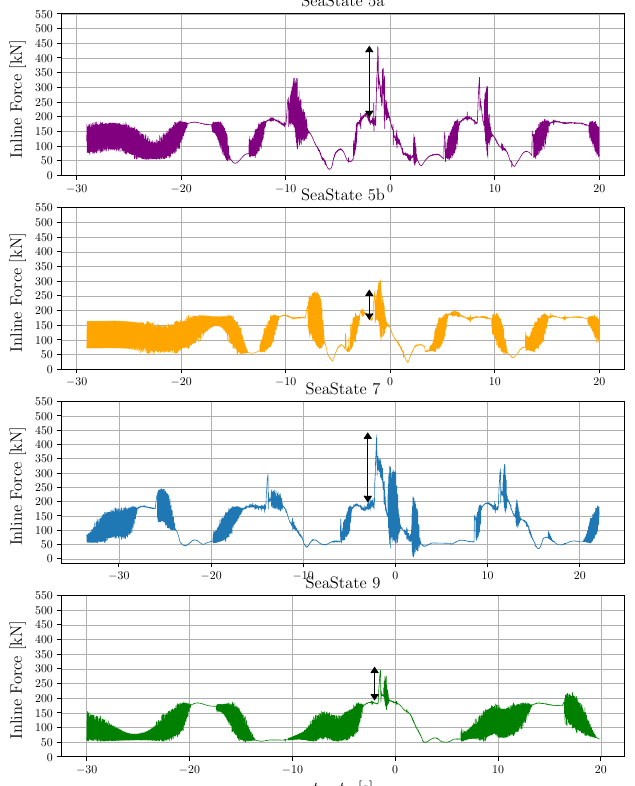
t f = 0 s , at the bottom). −